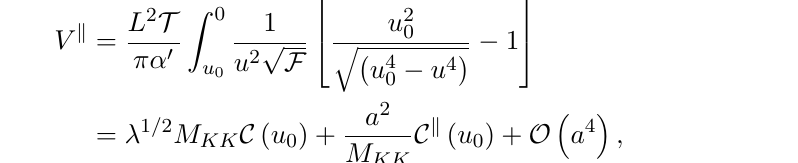
, C ⊥ as functions of u 0 k